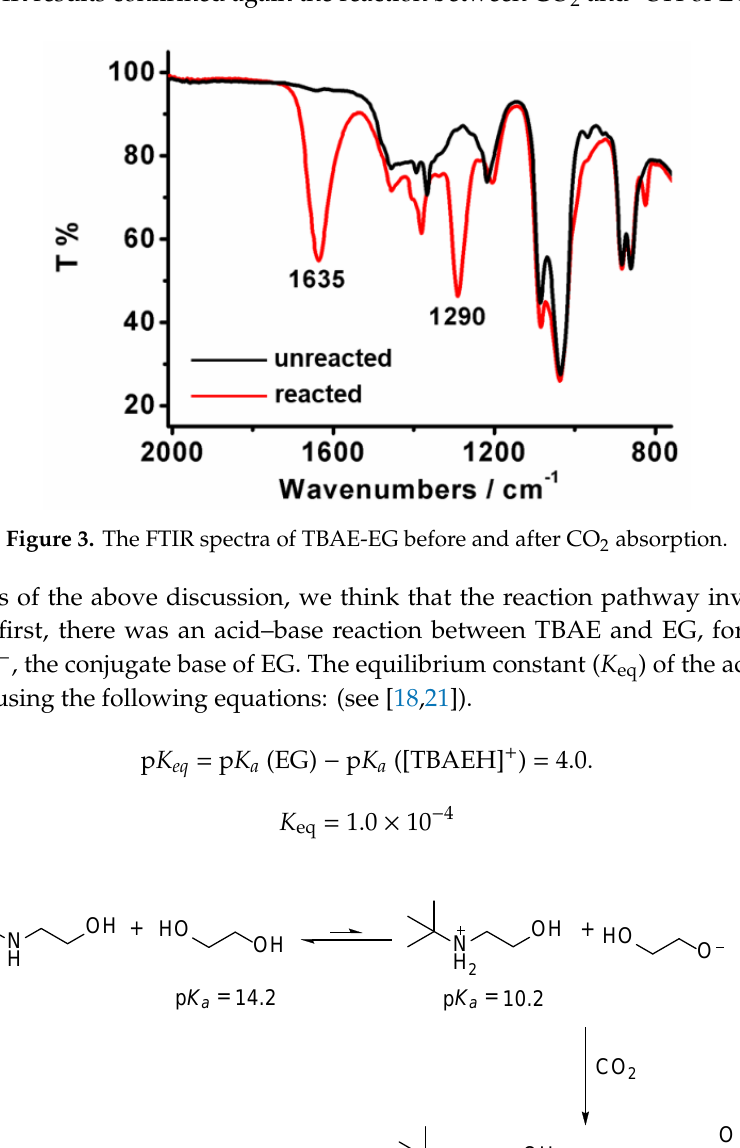
4 of 7 Figure 2. The 2D NMR spectra of TBAE-EG after CO 2 absorption: ( a ) 1 H- 13 C Heteronuclear Single Quantum Coherence ( 1 H- 13 C HSQC); ( b ) 1 H- 13 C Heteronuclear Multiple Bond Correlation ( 1 H- 13 C HMBC).